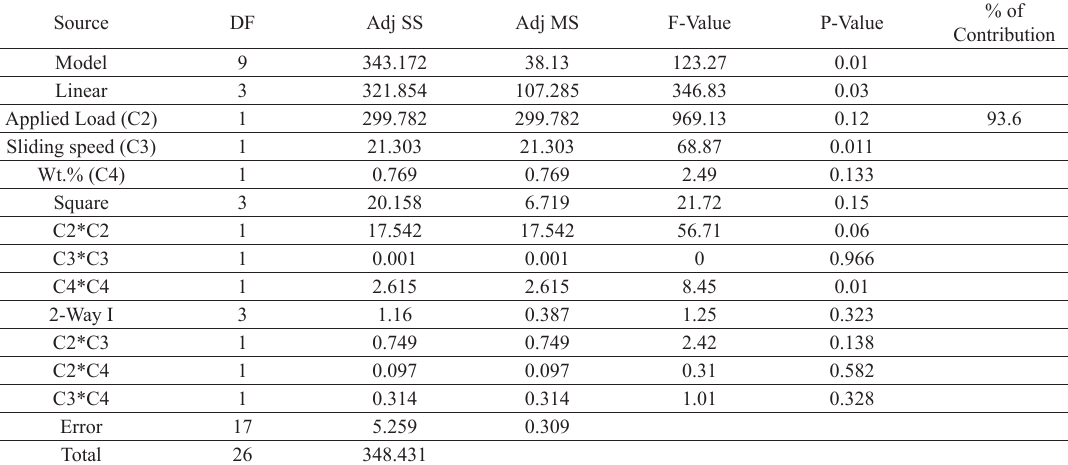
Table 4. Factor contribution of frictional